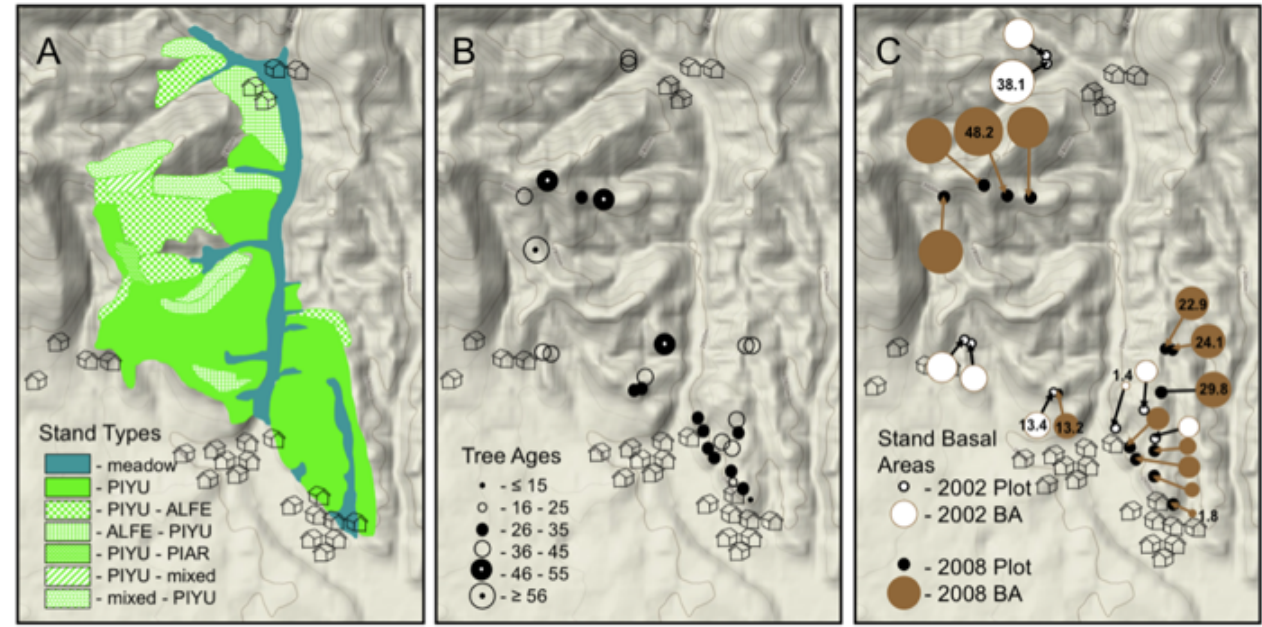
Fig. 3. Distribution of forest types, maximum tree ages, and stand basal areas in the Apiladda and Laizigou watersheds. (A) A rough approximation of the distribution of forest cover in the Apiladda and Laizigou watersheds, extrapolated from point data for 83 points collected during GPS surveys conducted along well-used forest and meadow trails. Shaded areas indicate variation in dominant and sub-dominant canopy species throughout the watershed: PIYU = Yunnan pine ( Pinus yunnanensis ); PIAR = Chinese white pine ( Pinus armandii ); ALFE = Alnus ferdinani-obergii; mixed as sub-dominant = PIYU, alder, or oak; mixed as dominant = PIAR, alder, oak, or rhododendron. Forest cover transitions from dry, open- canopy stands of stunted Yunnan pine to wet, closed-canopy, mixed conifer and hardwood forests with increased distance from villages and with increasing elevation and latitude in the watershed. Patterns in species distribution, tree age, and stand basal area agree with local accounts of periodic intensive harvests, as well as studies of grazing and chronic, low-intensity biomass removal; however, geophysical influences on forest cover have not been quantitatively isolated from anthropogenic influences. (B) The ages of the largest trees (PIYU or PIAR) sampled at the points indicated using an increment corer at breast height. (C) Basal area of trees, recorded in 2002 using tree counts and size measurements in 400-m² plots, and in 2008 using a keyhole prism. The circle size indicates relative basal area as a percentage of the largest recorded; specific basal areas are shown in tree area per ground area (m²/ha). Maximum tree age (B) and basal area (C) increase with elevation and distance from population